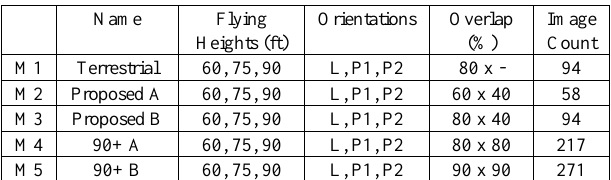
Table 2. Flight plan parameters; L – Landscape, P1 – Portrait -90° rotation from landscape, P2 – Portrait +90° rotation from landscape. Overlap percentages are denoted as forward and side lap, respectively.